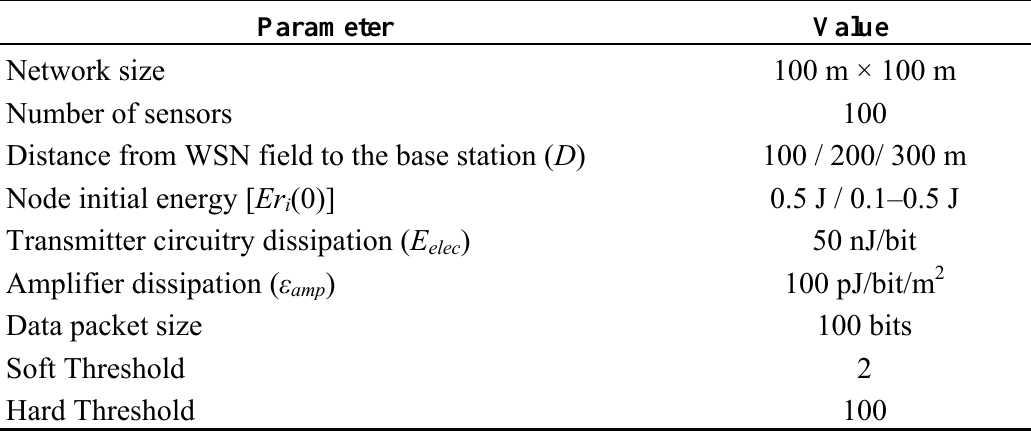
Table 1. Simulation